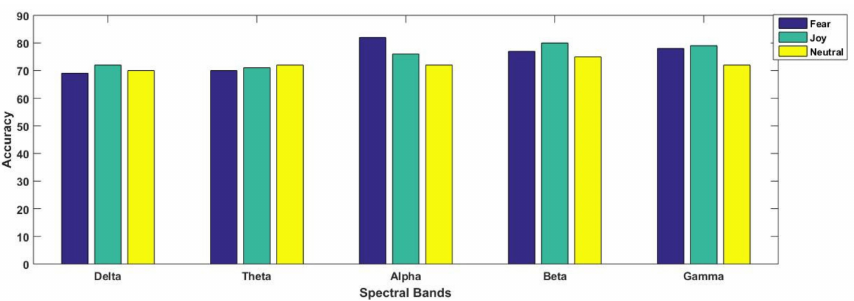
Figure 8. Comparing classification performance achieved for each of the three emotional states in each of the five considered spectral